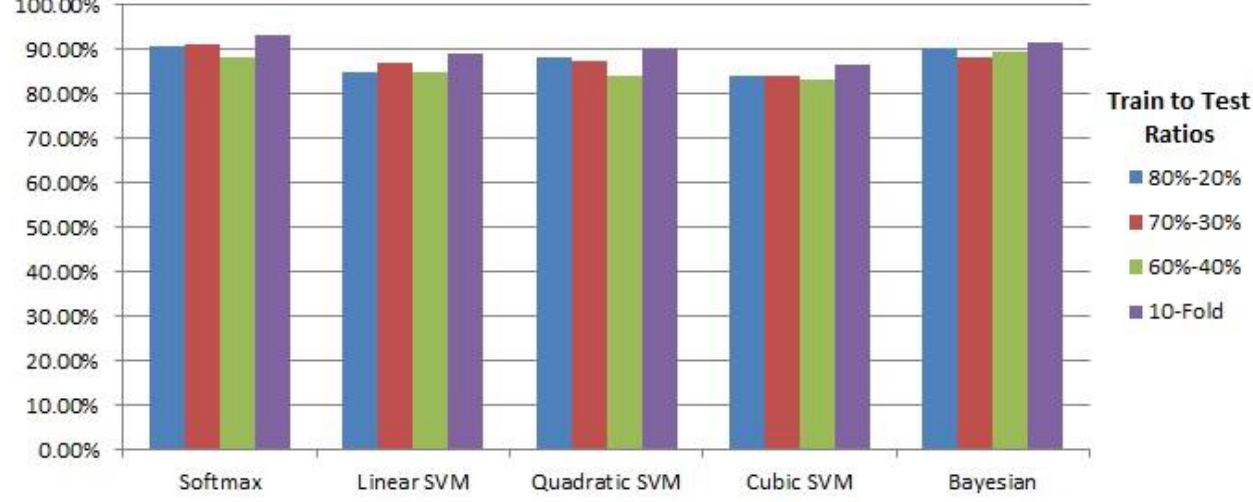
Figure 11. Accuracy results using contrast-enhanced images for various train-to-test ratios of mixed dataset (original images + augmented contrast enhanced images).